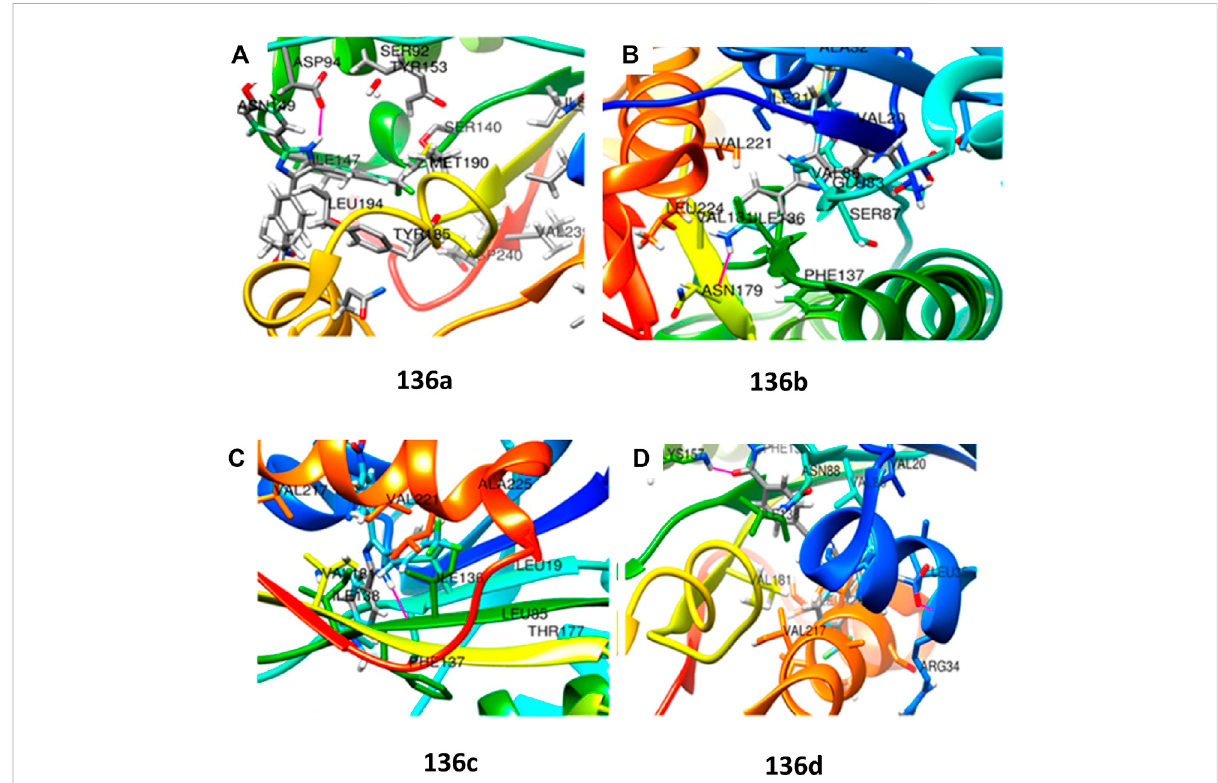
FIGURE 13 (A) Molecular docking of 136a with MabA protein. (B) Molecular docking of 136b with MabA protein. (C) Molecular docking of 136c with MabA protein. (D) Molecular docking of 136d with MabA protein. Reproduced from Raghu et al., 2020, with permission from American Chemical